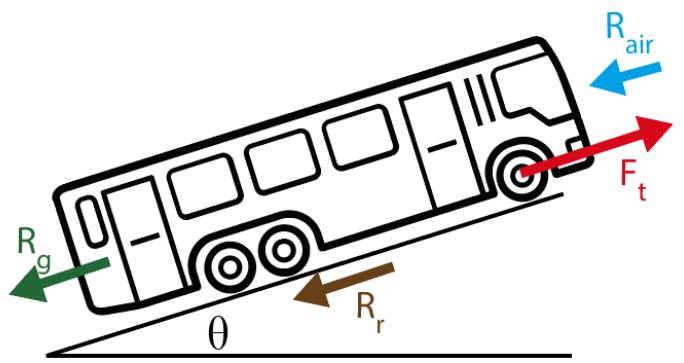
Figure 5. Forces acting on a moving